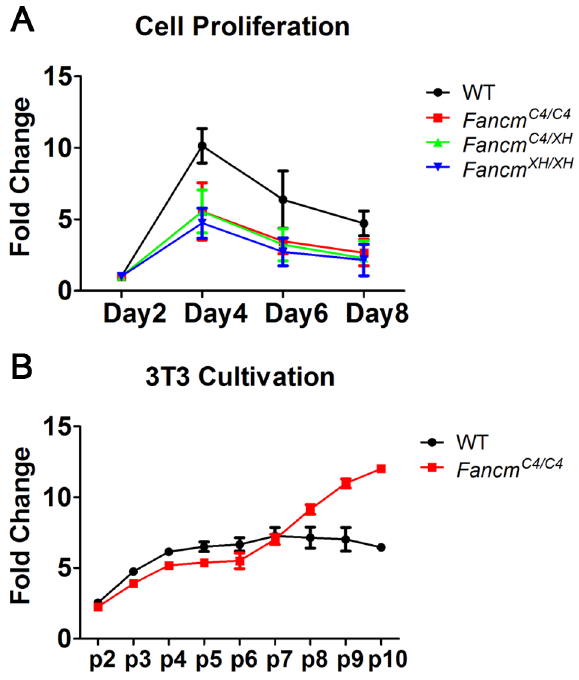
Figure 2. Fancm C4/C4 MEFs undergo premature senescence, but are not sensitive to interstrand crosslinks. (A) MEF growth assays. (B) Immortalization timeline of primary MEFs using a 3T3 growth protocol. Cultures were passaged every 3 days.